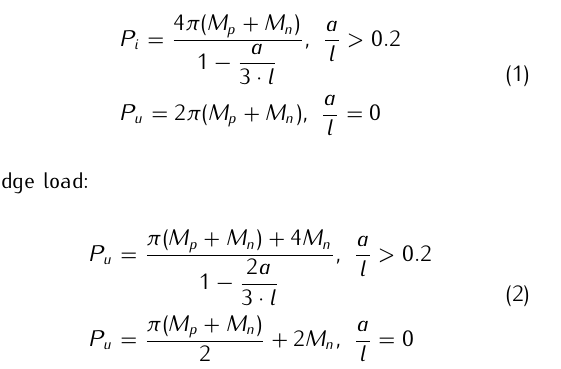
assumes that reactions from the subgrade are vertical only and can be represented by vertical elastic